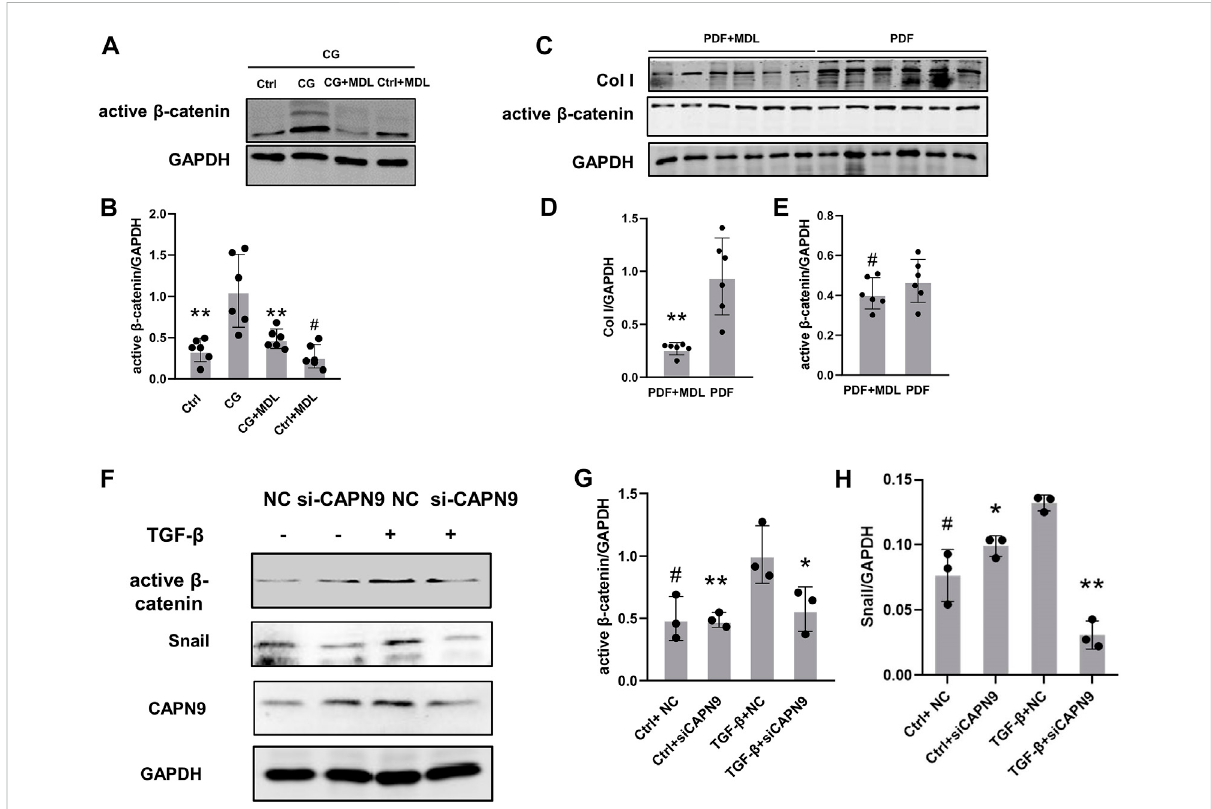
FIGURE 4 Chlorhexidine glucose treatment elevated the expression of active β -catenin in peritoneum and knockdown of Calpain9 resulted in down- regulationofactive β -catenin. (A – E) .Westernblottingshowedtheexpressionofactive β -catenin, snailandextracellularmatrixproteinsinperitoneal lysatesofmiceinchlorhexidineglucose(CG)group (A,B) andperitonealdialysis fl uid(PDF)group (C – E) . n =6pergroup.* p < 0.05,** p < 0.01,vs.CG or PDF group. # p > 0.05. vs control (Ctrl). (F – H) . The expression of active β -catenin and snail was detected with or without siRNA-CAPN9